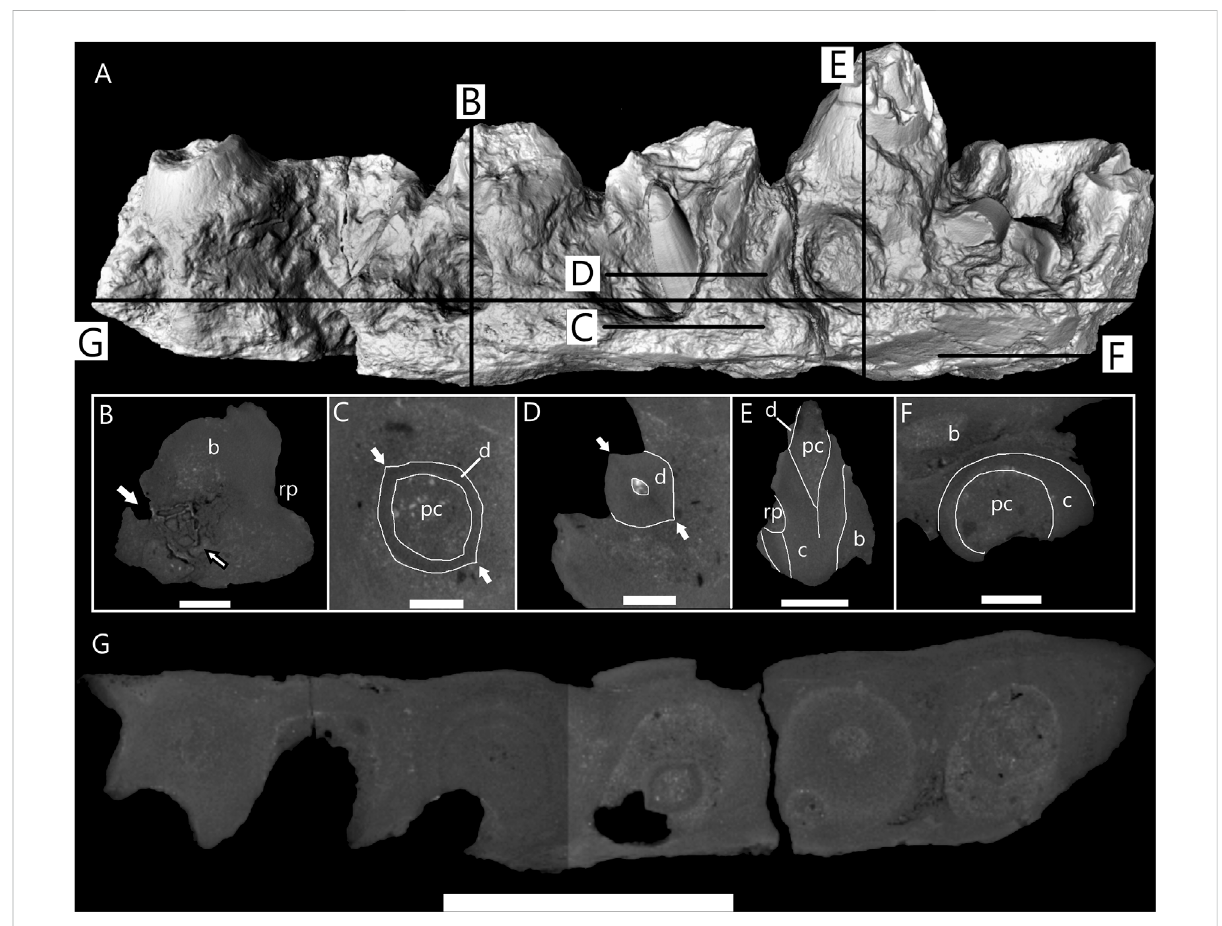
FIGURE 10 Micro-CT scan images of anterior dentary fragment of cf. Taniwhasaurus (SAM-PK-5265). (A) Three-dimensional micro-CT image of anterior dentary fragment with lines to indicate location of sections shown in B-G. (B) Longitudinal section through fragment at position of fourth functional toothpositionshowingresorptionpitonmedialsideandoneforamina(whitearrow)ondistalside.Blackoutlinedarrowpointstounusualbonetissue next to foramen. (C) Horizontal section through dentary showing base of second replacement tooth (RT-2) crown. It is ovate shape with two distinct carinae (white arrows) and large pulp cavity. (D) Horizontal section through dentary showing cross-sectional shape of RT-2 halfway up crown.Maintainsovateshapewithtwocarinae.Smoothfacetsarevisibleonsurfaceoftoothinbothhorizontalsectionandthree-dimensionalimage (A) . (E) Longitudinal section through second functional tooth showing various tooth tissues, discernible by density differences. Pulp cavity in fi lled with sediment and most of dentine lost. (F) Horizontal section taken near ventral surface where cementum of fi rst tooth visible. Suggests signi fi cant amount of bone missing from ventral surface of dentary. (G) Horizontal section through entire dentary fragment showing each tooth position and visible changes in density between different tissues. Abbreviations: bone tissue (B) ; cementum (C) ; dentine (D) ;resorption pit (rp). Scale bars: (A,G) = 50 mm; (B) = 10 mm; (C,D) = 6 mm; (E) = 20 mm; (F) = 8.5